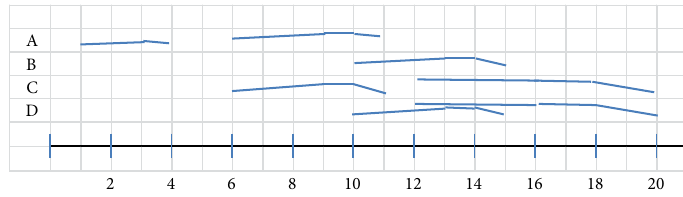
Figure 4. Schedule according to the latest dates using fuzzy values